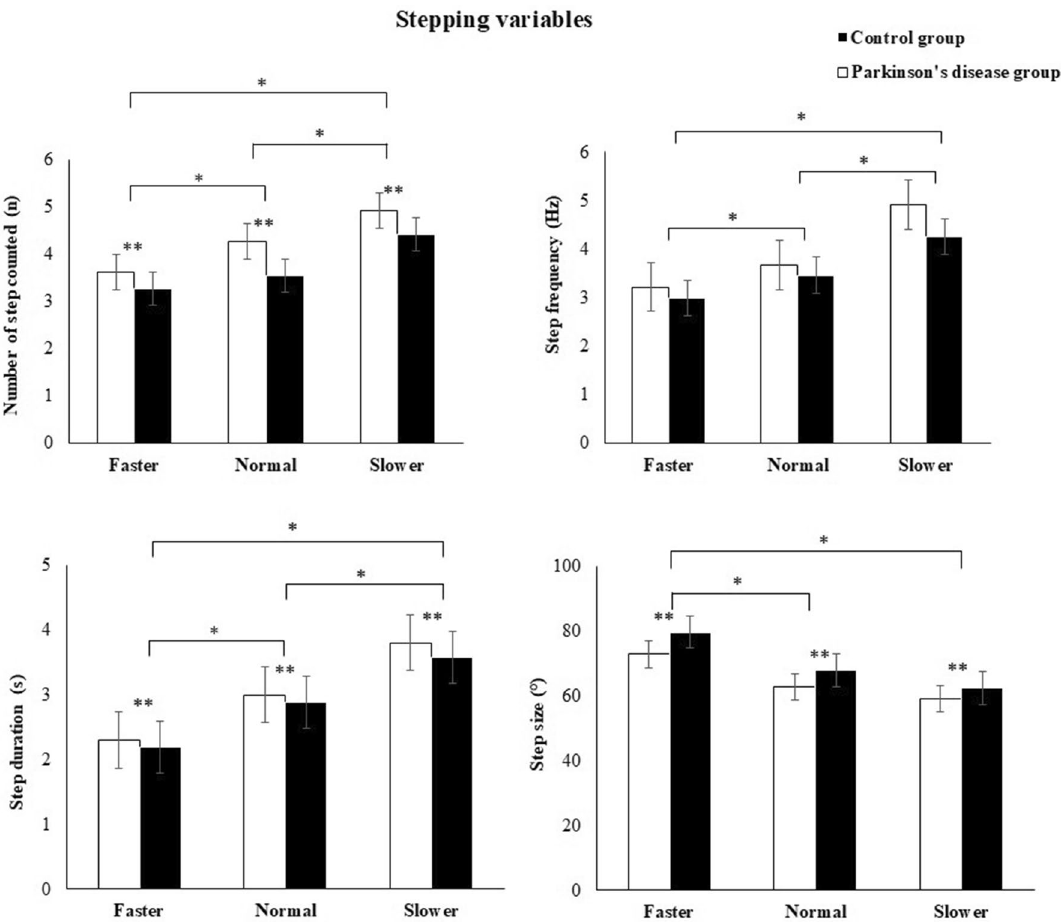
Figure 4. Bar graph of the results of s tepping variables showing changes in turning speed and differences between groups (*—significant main effect of turn speed and **—significant main effect of